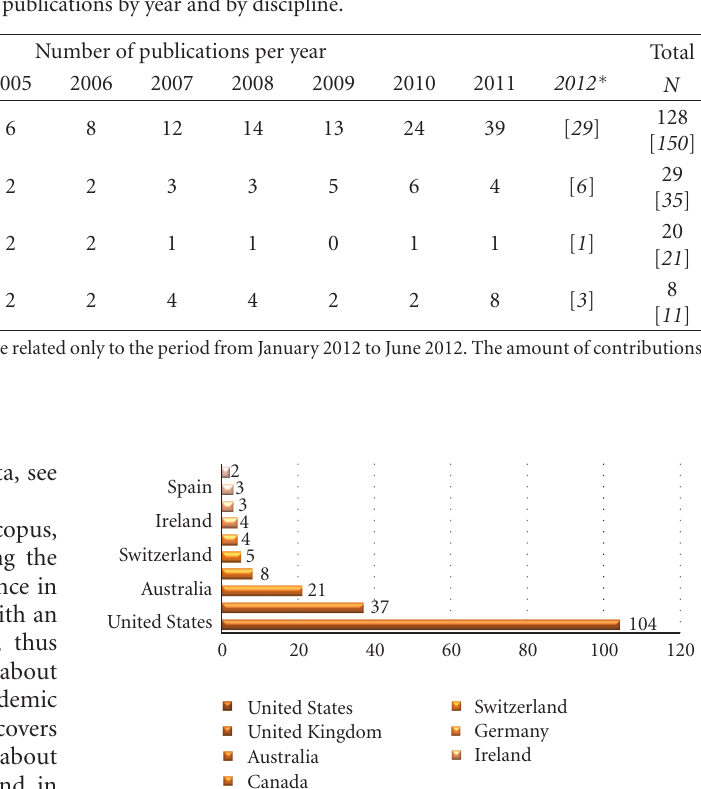
Table 2: Number of publications by year and by discipline.